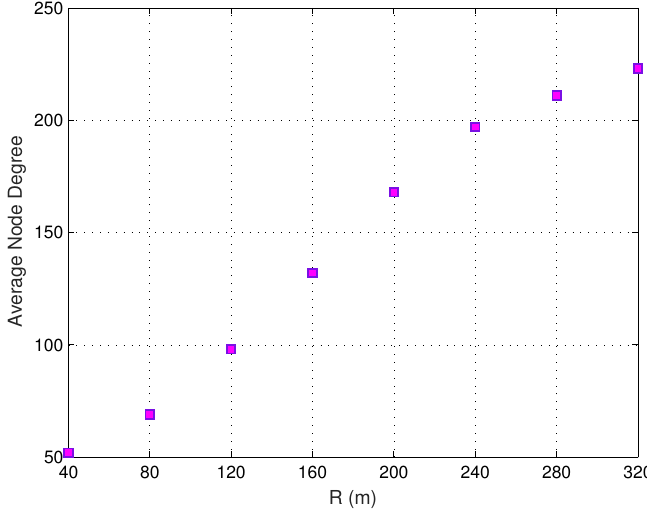
Figure 8. The relationship between the range and the average node degree for first